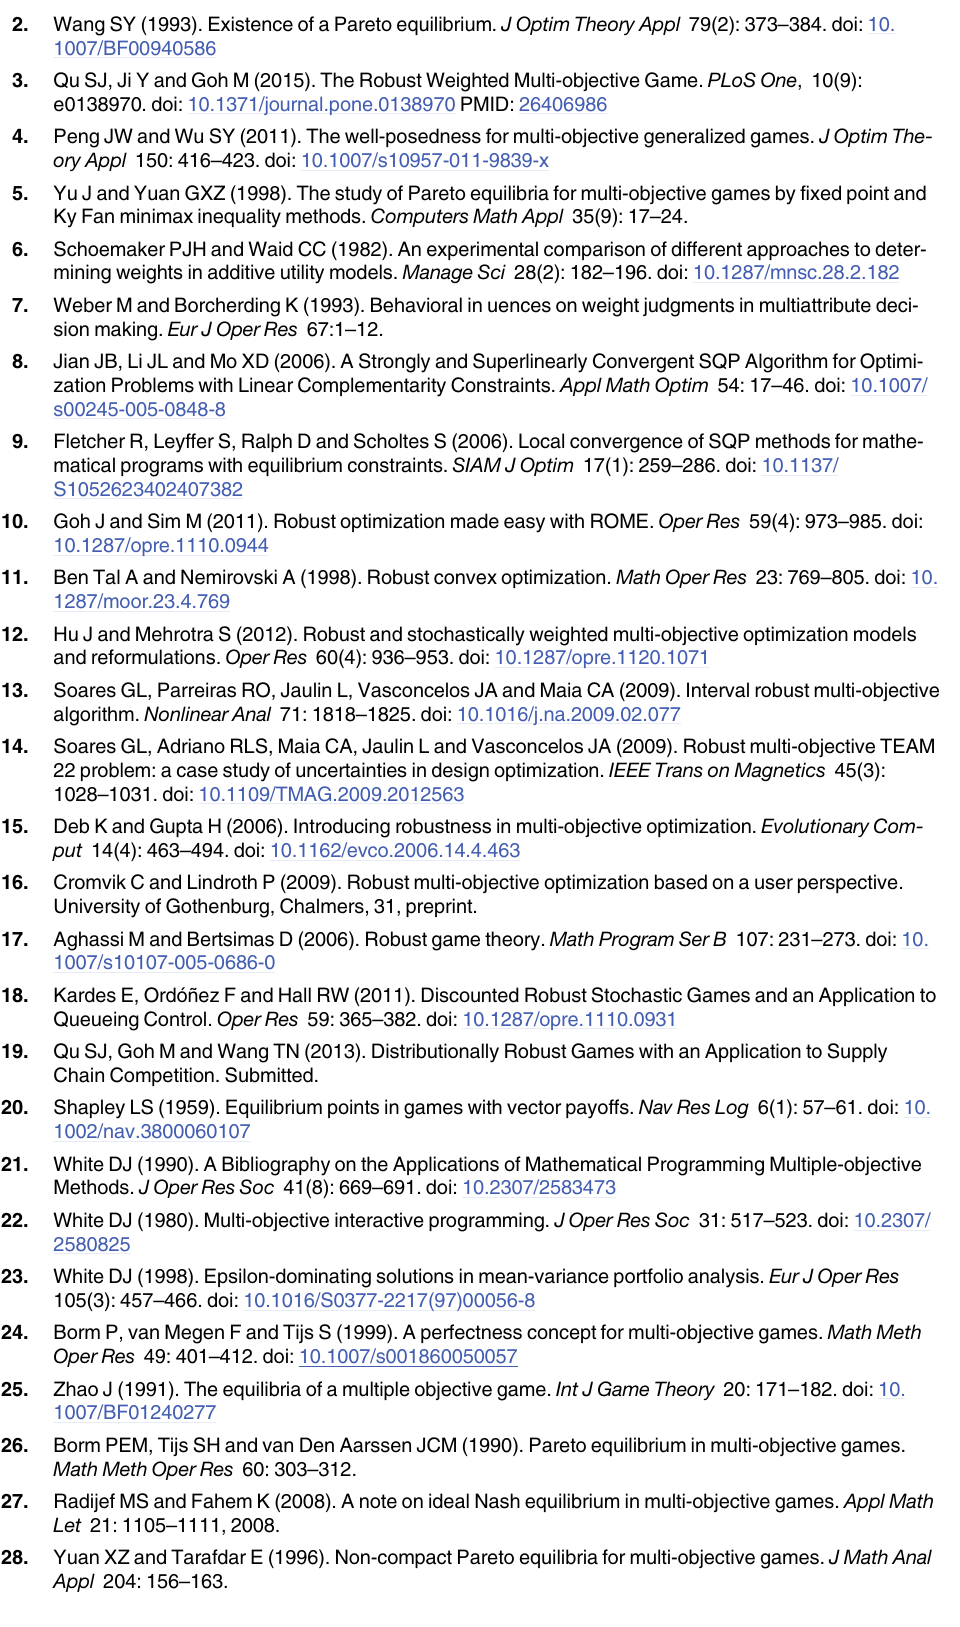
PLOS ONE | DOI:10.1371/journal.pone.0147341 January 28,